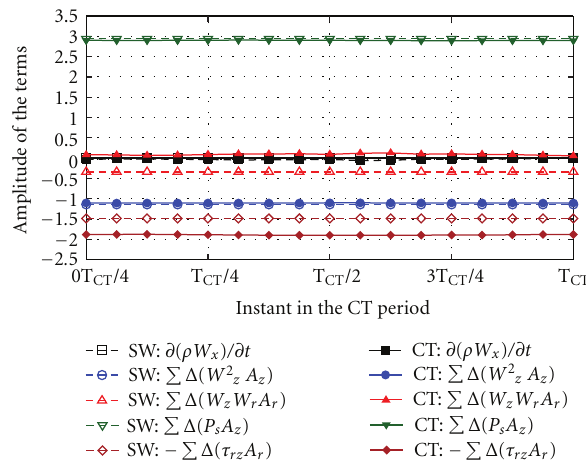
Figure 14: CREATE-R2 with and without CT: temporal evolution of the main terms of the unsteady axial momentum equation.